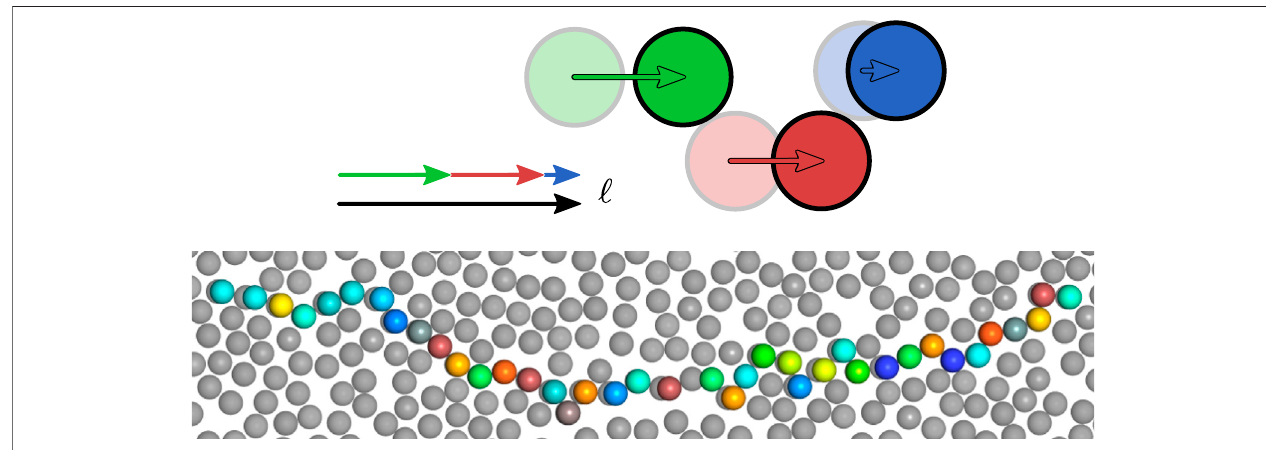
FIGURE 1 | The upper scheme illustrates the billiard -type construction of an EC with a total displacement length ℓ and with three participating spheres. The lower pictureshowstheexampleofatypicalECinadensehard-spheresystem:thecoherentmovementoflongline-likeclustersineachECMCmoveacceleratesthesampling by nearly two orders of